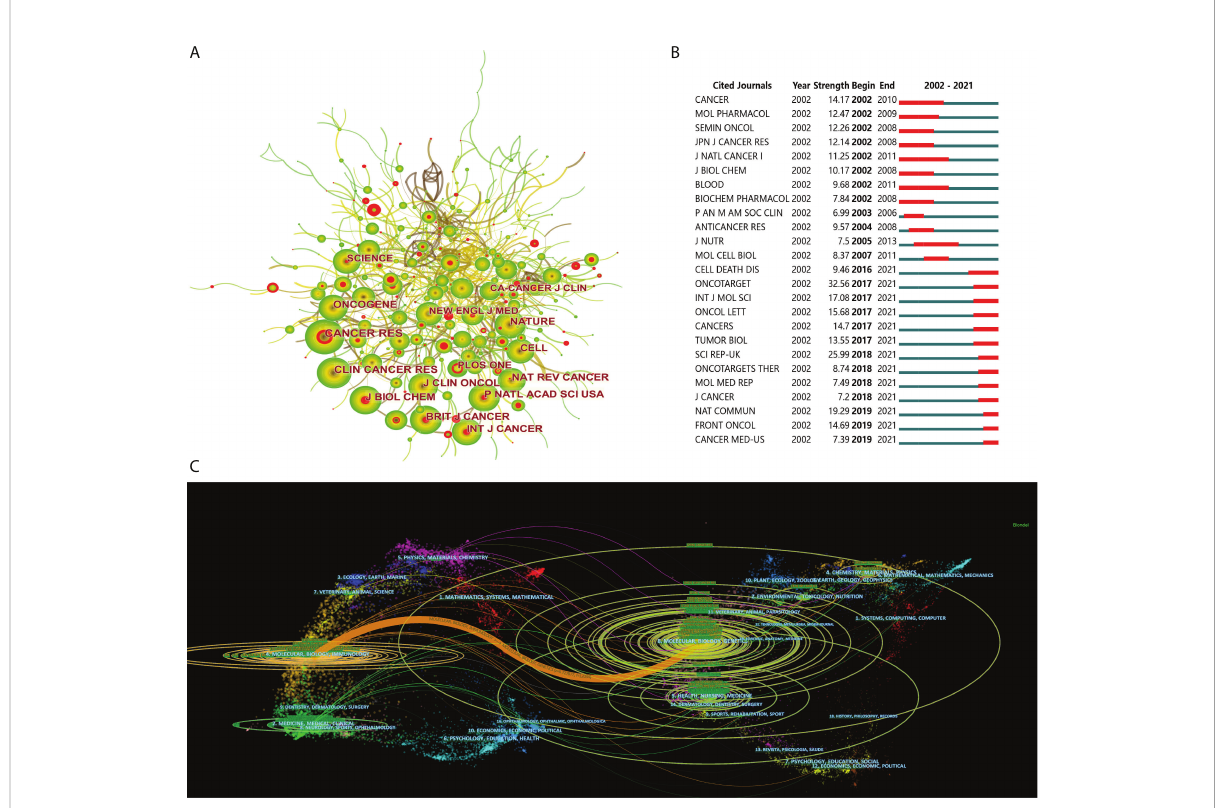
FIGURE 5 The contributions of journals in drug resistance and colorectal cancer. (A) Journals co-citation analysis. The nodes represent journals, and the lines mean citations between them. The publication number is proportional to the size of nodes, and the thickness of the connecting line is proportional to the degree of citations. The red core of the nodes represents stronger citation bursts. From 2002 to 2021, the color changed from yellow to green. (B) Top 25 cited journals with the strongest citation bursts. The blue line represents the time axis, and the red portion on the blue time axis The contributions of journals in drug resistance and colorectal cancer. (C) The dual-map overlay of journals related to colorectal cancer drug resistance. On the left were the citing journals, on the right were the cited journals, and the colored path represented the citation relationship.